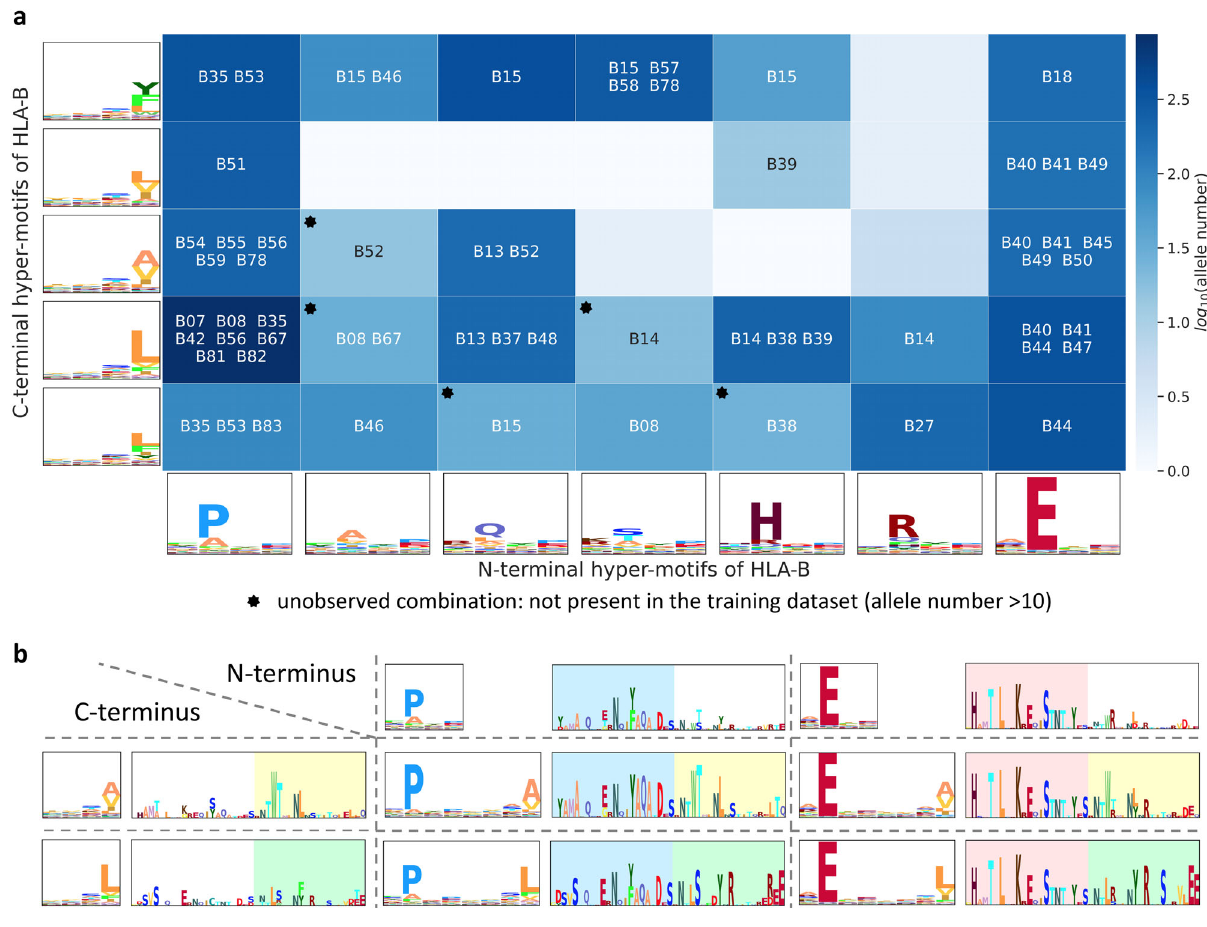
Fig. 5 The combination map of N- and C-terminal hyper-motifs. a The binding motif of an allele is a combination of an N-terminal and a C-terminal hyper- motif. After allocating all the alleles into the combination map, the cell color is determined by log 10 (number of alleles in the cell). In each cell with an allele number >10, the maximal HLA group and HLA groups with an allele number ≥ 25 or with a proportion (the allele number in the cell to the overall number of an allele group) >0.1 are listed. b The relation of a combination to its hyper-motifs. Four combinations are used as an example to illustrate the consistent signatures across different cells in the same column or row. The header column and header row consist of two N-terminal and two C-terminal clusters, respectively. Then, alleles of a cell, the combination of the N-terminal (column) and C-terminal (row) clusters, are used to generate the corresponding hyper-motif and allele signature. The color boxes are used to highlight the similar part of allele signatures. Source data are provided in Supplementary Data